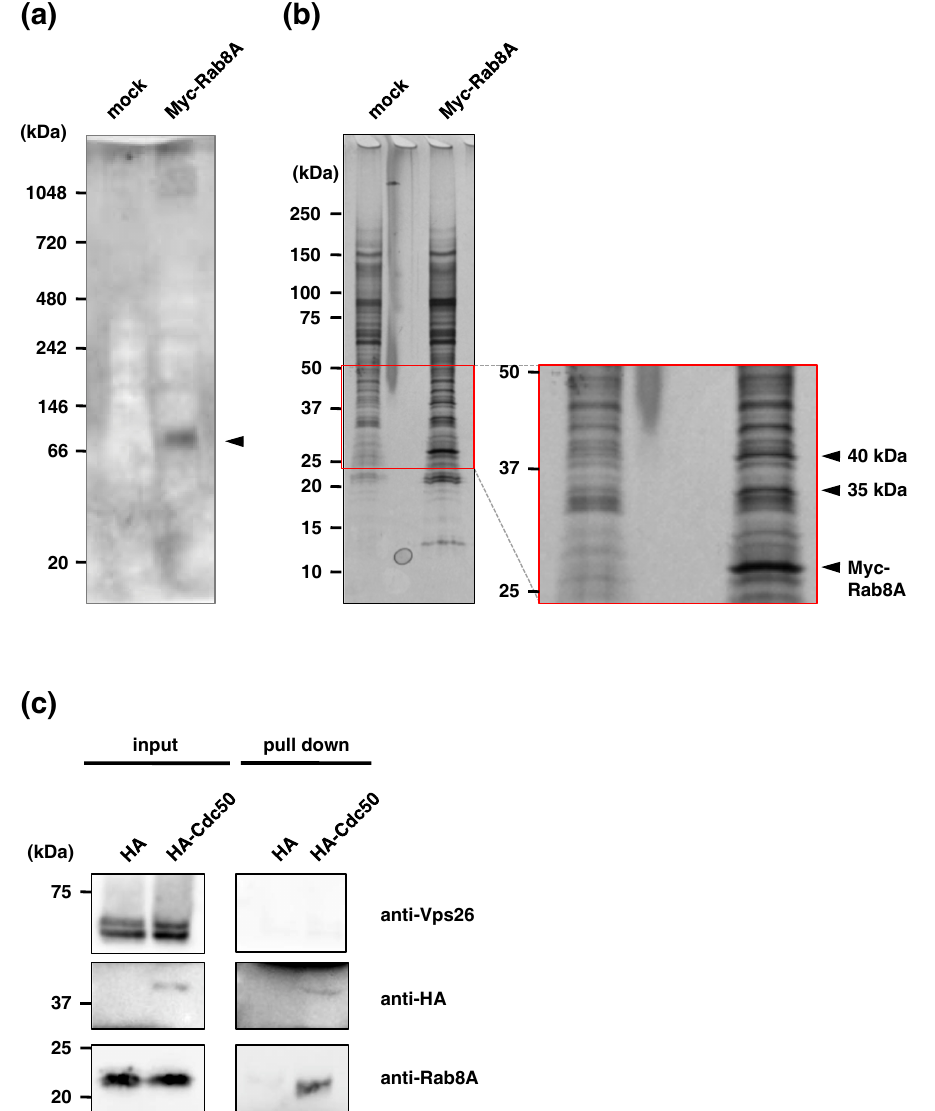
Figure 1. Identification and confirmation of EhCdc50 as an EhRab8A binding protein. ( a ) Immunoblot analysis of Myc-EhRab8A with anti-Myc antibody following BN-PAGE from representative image of three independent experiments. ( b ) SDS-PAGE analysis of Myc-EhRab8A-binding proteins. Myc-EhRab8A-binding proteins coimmunoprecipitated with anti-Myc antibody were separated on SDS-PAGE and detected with silver staining. Representative data of three independent experiments was shown. ( c ) Reciprocal coimmunoprecipitation of EhRab8A via interaction with EhCdc50. EhCdc50 binding protein was immunoprecipitated from lysates of HA-EhCdc50-expressing cells with anti-HA antibody, followed by immunoblotting with anti-HA, anti-EhRab8A and anti-EhVps26 antibodies. Anti-EhVps26 antibody was used as a negative control.